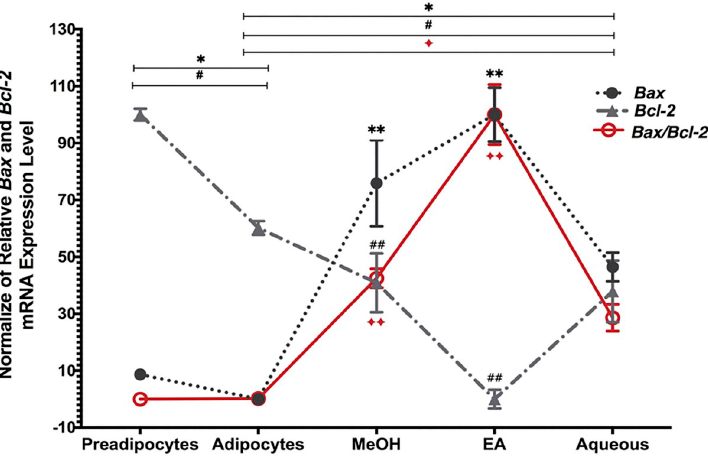
Fig 4. qRT-PCR data showing the effect of B . spergulifolius extracts on apoptosis regulated by the Bax and Bcl-2 in 3T3-L1 adipocytes. The expression at the mRNA level of Bcl-2-associated X (Bax) and B-cell lymphoma-2 (Bcl-2) genes and Bax / Bcl-2 ratio was detected by qRT-PCR in preadipocytes, mature adipocytes without B . spergulifolius extracts and adipocytes treated with IC 50 dose of MeOH, EA and Aqueous of B . spergulifolius extracts for 24 h. The Glyceraldehyde-3-phosphate dehydrogenase ( Gapdh) gene was used for normalization. qRT-PCR was analysed using the comparative threshold cycle C T method ( ΔΔ C T ) from three independent experiments. Data are expressed as the relative change of the ΔΔ C T and the means ± SD. To analyse statistical was used Student’s t-test (two-tailed). � p < 0.05, # p < 0.05, and ✦ p < 0.05, significantly different from mature 3T3-L1 Adipocytes. �� p < 0.05, ## p < 0.05, and ✦✦ p < 0.05, significantly different from